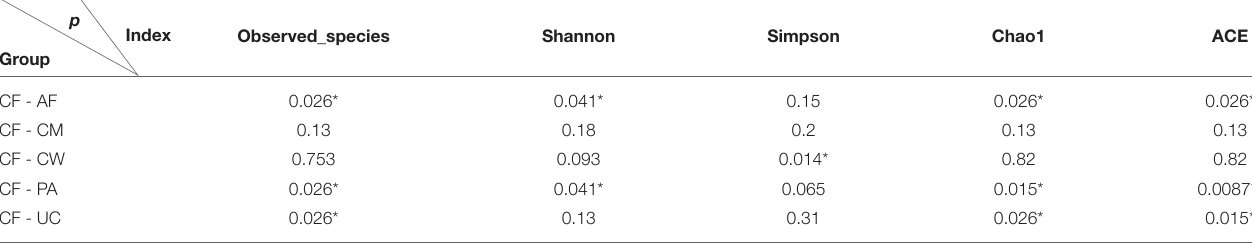
TABLE 3 | Wilcox test of alpha diversity index for meconium and maternal parts.